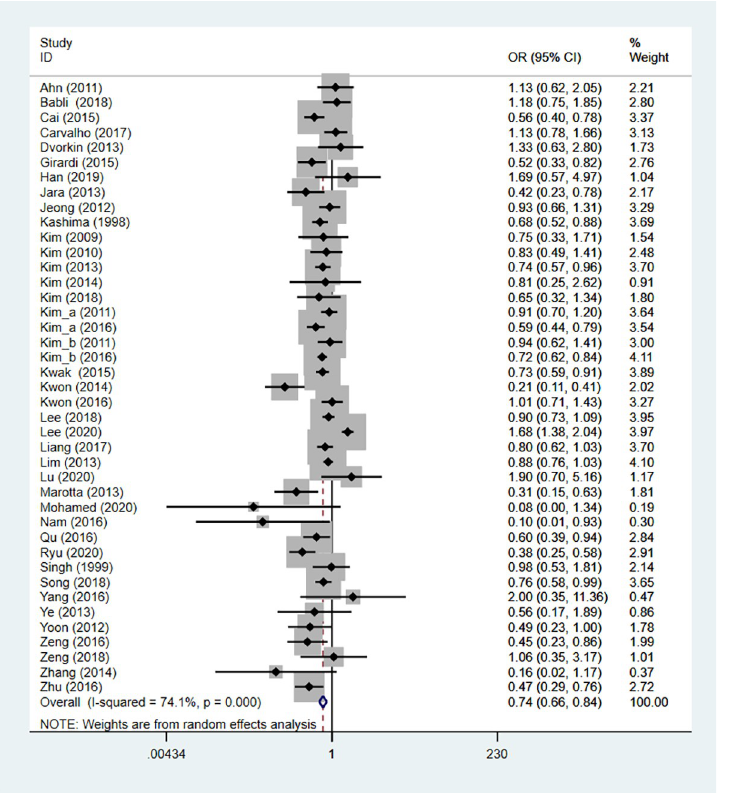
Fig 4. The forest plot of extrathyroidal extension between HT group and non-HT group.